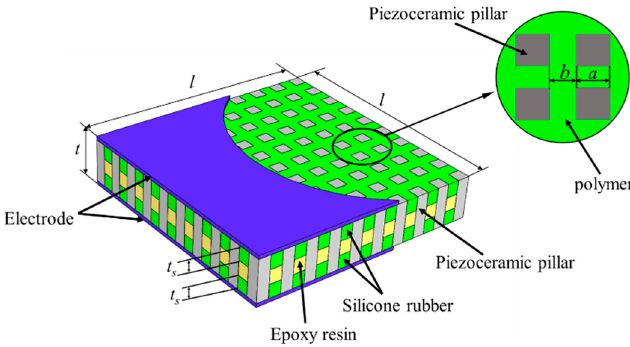
Figure 1. Structure of the 1-3 piezoelectric composite with 3-tier polymer structure.